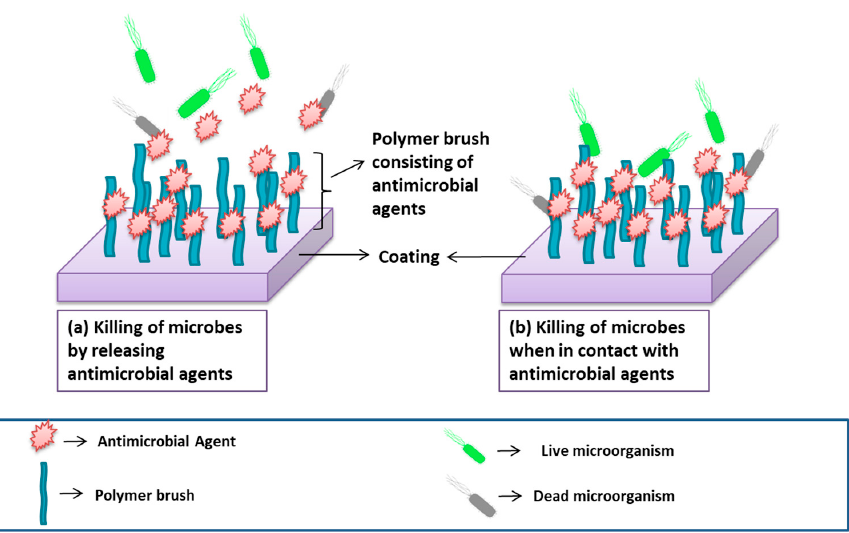
Figure 26. The schematic demonstration of coating consisting of two types of polymer brushes: ( a ) releases antimicrobial agents to kill the microbes and ( b ) kills microbes when in contact with